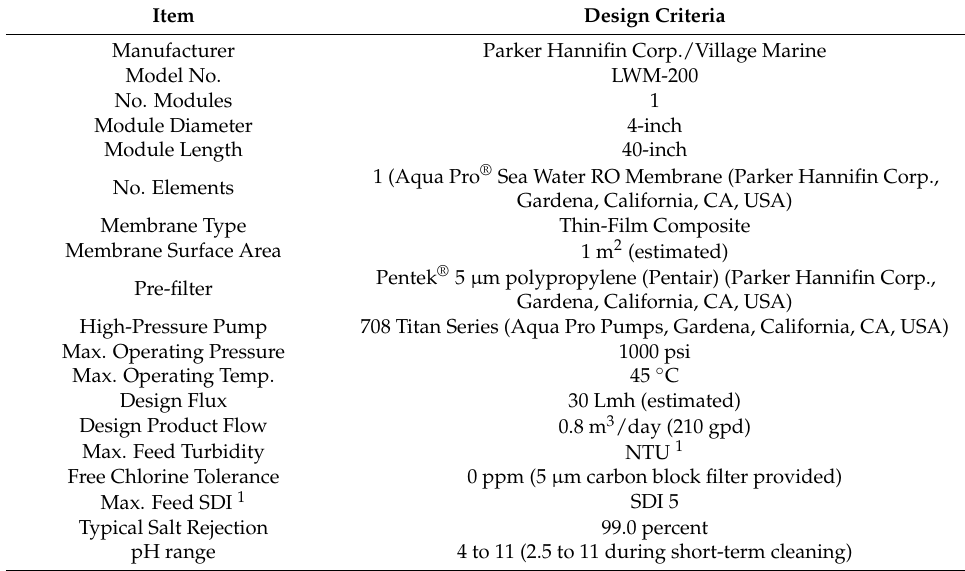
Table 2. Bench Scale Sea Water Reverse Osmosis (SWRO) System Specifications